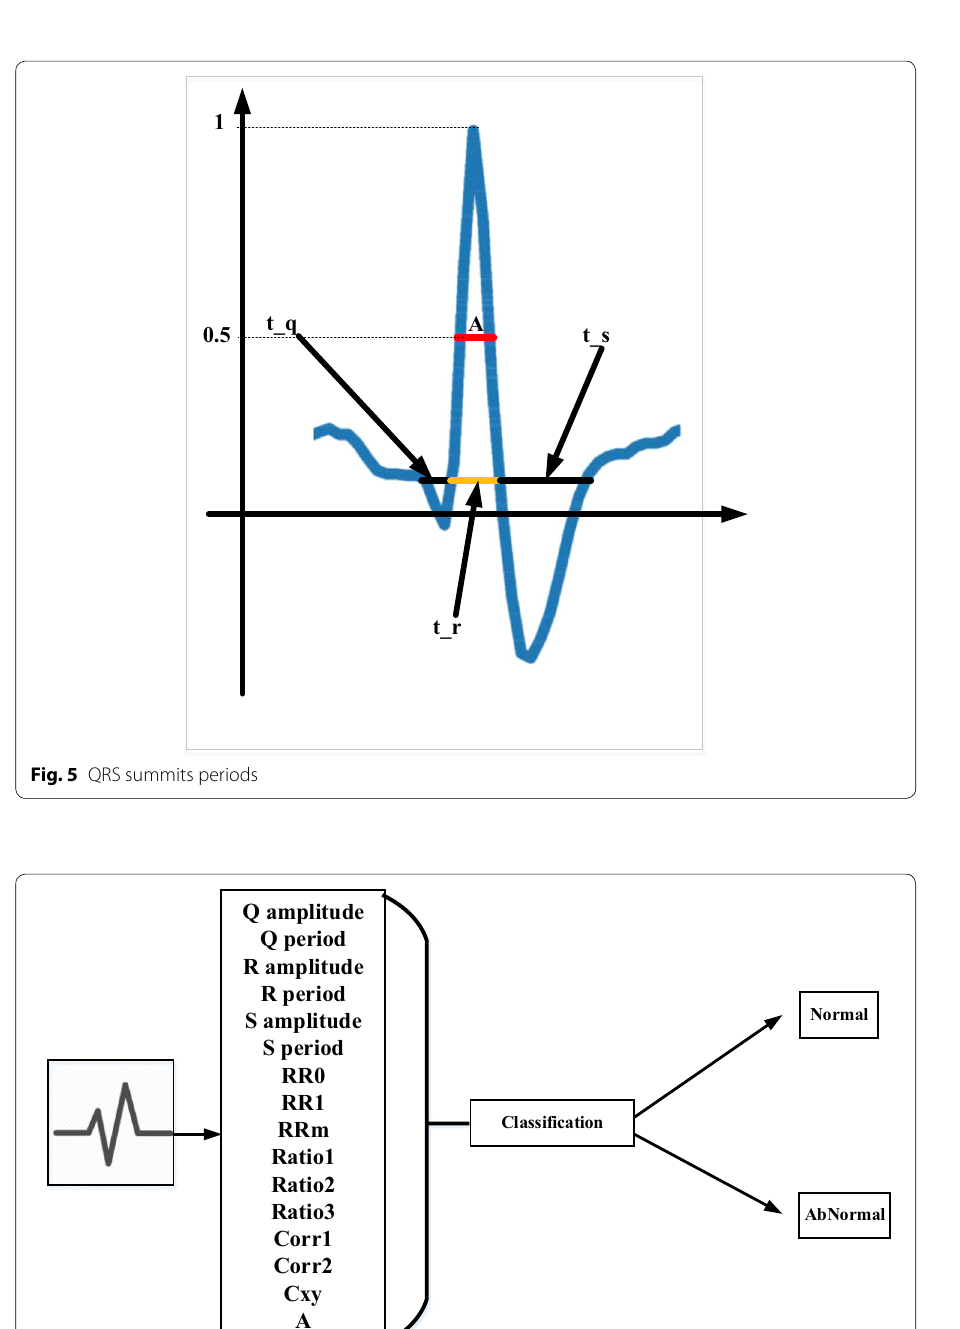
For features selection, many tests have been done to get best features for final model.